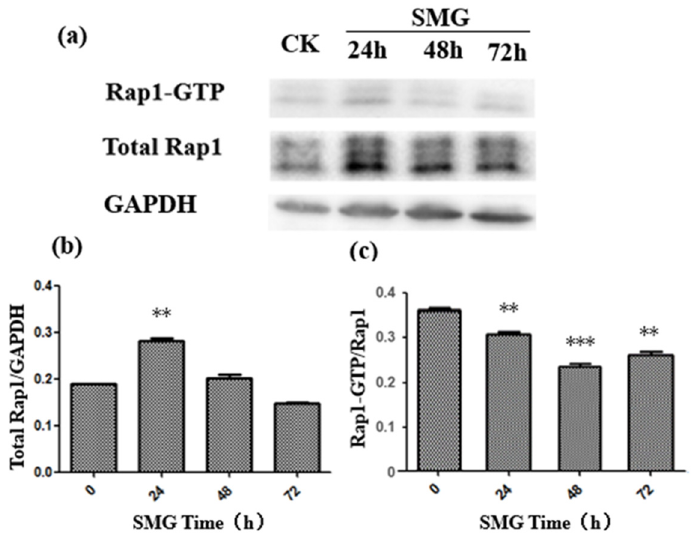
Figure 4. The activation of Rap1 was down-regulated by SMG. Expression and activation of Rap1 protein under SMG for 24, 48, and 72 h were detected by Western blot and GST pull-down assay, respectively. ( b ) The relative Rap1 expression under SMG for 24, 48, and 72 h was calculated based on panel ( a ). ( c ) The relative activation of Rap2 under SMG for 24, 48, and 72 h was determined based on panel ( a ). The statistical results shown represent the means ( n = 3) vs. the control group ( n = 3); ** p < 0.01, *** p < 0.001.